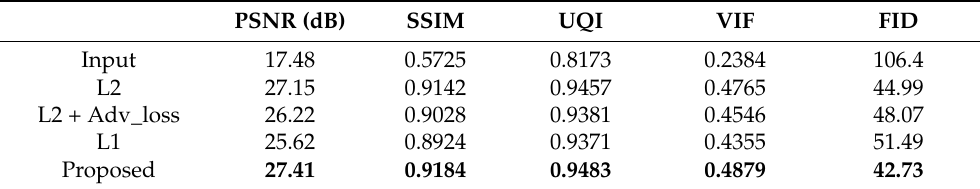
Table 5. Quantitative results for the noise level of sigma 25 compared with different loss functions. Bold results show good